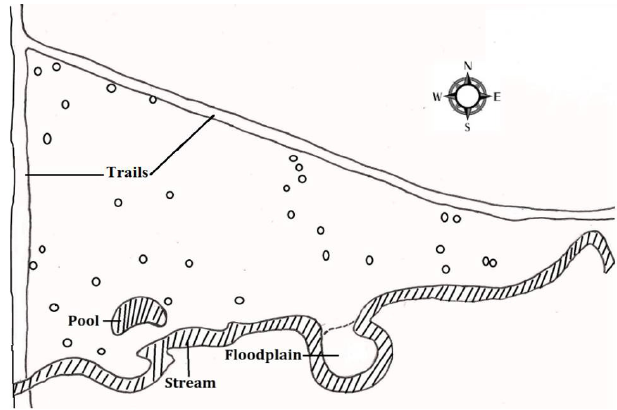
Fig 1 . Study area in the Arena Forest Reserve at 10°34’41”N 61°14’35”W. Circles indicate sites of known Pachycondyla crassinoda nests. Several of theseeach represent two apparently distinct colonies very close to each